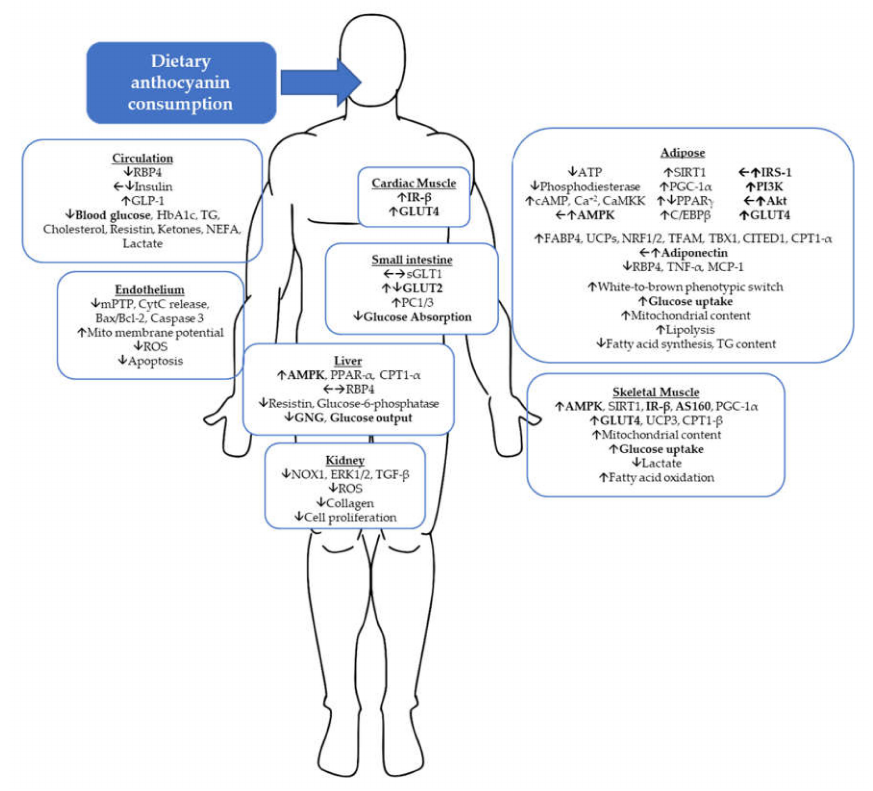
Figure 3. Summary of anthocyanin action on molecular targets and corresponding functional changes across tissues. Up-arrow; increased expression, activation, function, or concentration, sideways-arrow; no change, and down-arrow; a decrease. Multiple arrows on the same target indicate different findings acrossdiscussedstudies. Boldedtargetsaredirectlyrelatedtoglucosetransportersandglucosehomeostasis. RBP4; retinol bindingprotein 4, GLP-1; glucagon-like peptide1, HbA1c; hemoglobinA1C, TG; triglycerides, NEFA; non-esterified fatty acids, mPTP; mitochondrial permeability transition pore, CytC; cytochrome C, ROS; reactive oxygen species, IR- β ; insulin receptor-beta, GLUT4; glucose transporter type 4, sGLT1; sodium / glucose cotransporter 1, GLUT2; glucose transporter type 2, PC1 / 3; proprotein convertase 1 / 3, AMPK; adenosine monophosphate activated protein kinase, PPAR- α ; peroxisome proliferator-activated receptor, CPT1- α ; carnitine palmitoyl transferase 1, GNG; gluconeogenesis, NOX1; NADPH oxidase 1, ERK1 / 2; extracellular signal-regulated kinase 1 / 2, TGF; transforming growth factor, cAMP; cyclic adenosine monophosphate, CaMKK; Ca 2 + / calmodulin-dependent protein kinase kinase, SIRT1; sirtuin 1, PGC-1 α ; peroxisome proliferator-activated receptor gamma coactivator 1, C / EBP; CCAAT / enhancer-binding protein, IRS-1; insulin receptor substrate 1, PI3K; phosphatidylinositol 3-kinase, Akt; protein kinase B, FABP4; fatty acid binding protein 4, UCP; uncoupling protein, NRF; nuclear response factor, TFAM; mitochondrial transcription factor A, TNF; tumor necrosis factor, MCP-1; monocyte chemoattractant protein 1, AS160; Akt substrate